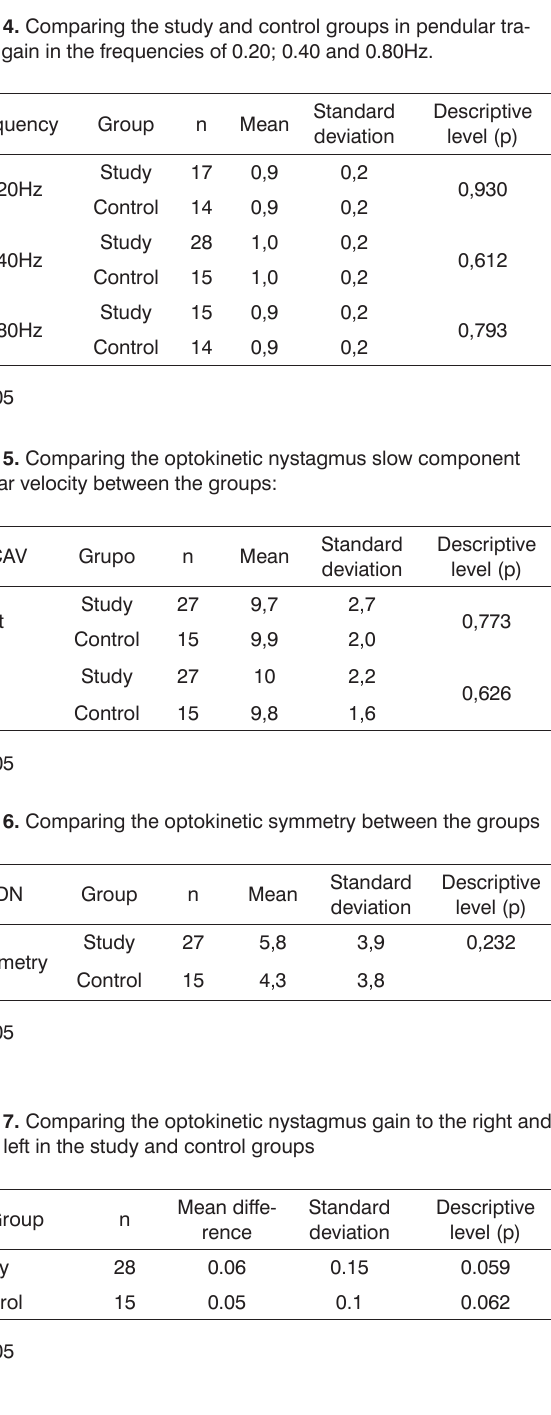
Table 4. Comparing the study and control groups in pendular tra- cking gain in the frequencies of 0.20; 0.40 and 0.80Hz. Frequency Group Mean